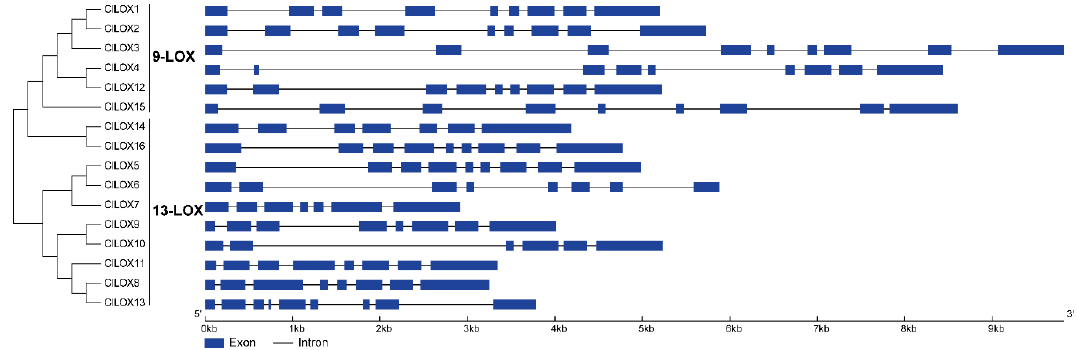
Figure 4. Exon-intron arrangements of watermelon LOX genes according to phylogenetic analysis. The exons and introns are shown as blue boxes and black lines, respectively.